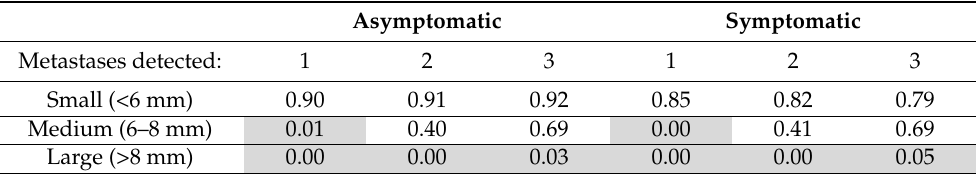
Proportions of oligo+ per risk sub-group. Grey fields represent the low-risk group. Table A5. Proportion of oligo+ within patients with detected oligo-metastases in the R Lower scenario.